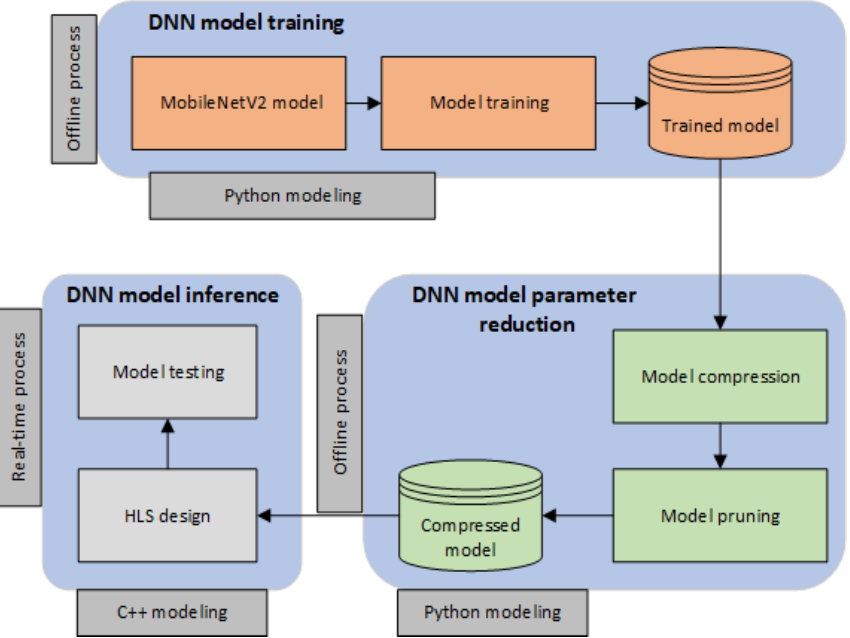
Figure 3. The design space exploration methodology we employ to validate our